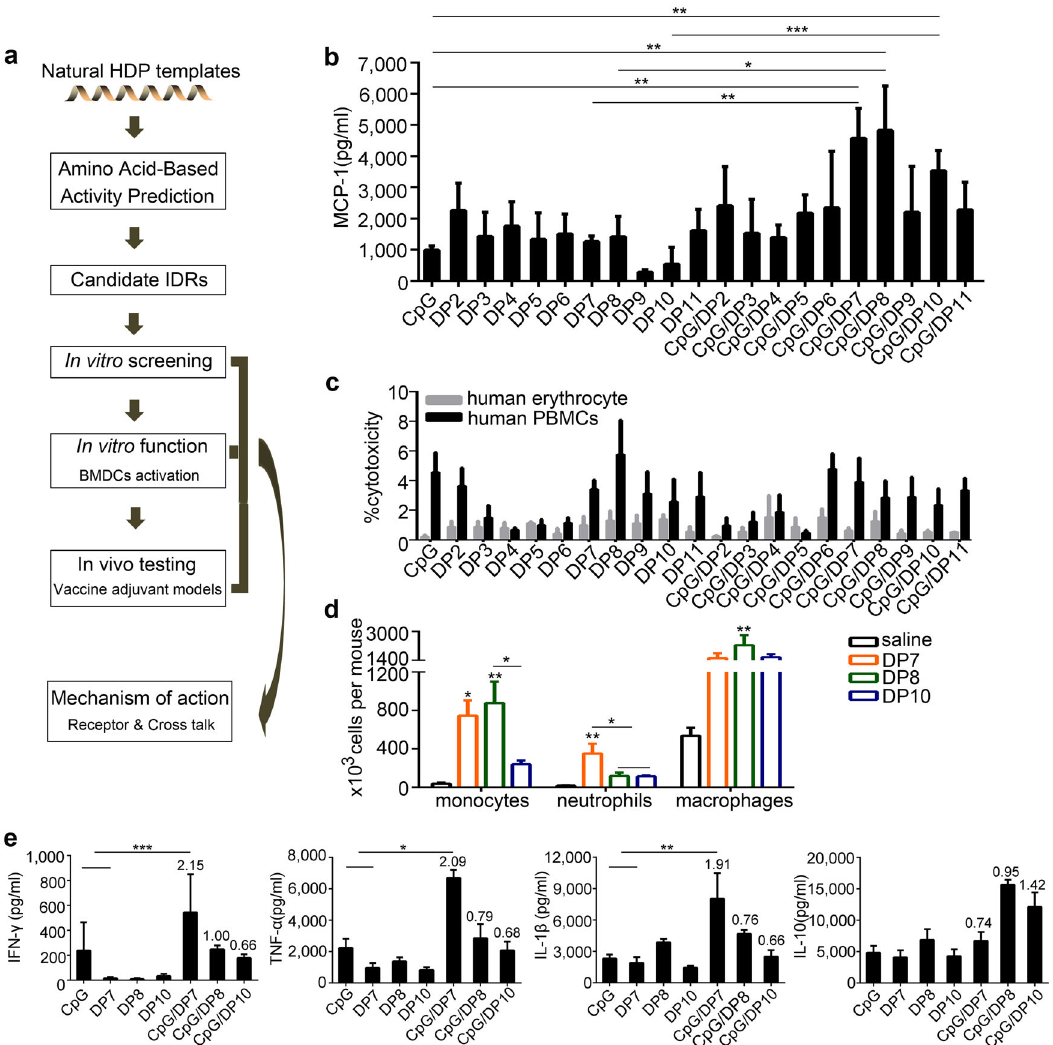
Fig. 1 In vitro preliminary screening of defense peptide candidates. a A representative fl owchart of the IDR design. b PBMCs were stimulated with CpG (20 µg/ml), DP2-11 (40 µg/ml), or CpG: DP2-11 (1:2; wt/wt) formulations for 24 h. The secretion of MCP-1 was detected by ELISA. c PBMCs or human erythrocytes were incubated with CpG (20 µg/ml), DP2-11 (40 µg/ml), or CpG/DP2-11 (1:2; wt/wt) formulations for 24 h. After that, the supernatants were collected, and LDH release from PBMCs and total hemoglobin release from red blood cells were measured. d DP7, DP8, and DP10 induced the signi fi cant recruitment of neutrophils (Gr1 + F4/80 − ), monocytes (F4/80 + Gr1 + ), and macrophages (F4/80 + CD11b + ) to the injection site at 24 h post-injection ( N = 5/group) . e PBMCs were stimulated with CpG (20 µg/ml), DP7 (40 µg/ml), DP8 (40 µg/ml), DP10 (40 µg/ml), CpG/DP7, CpG/DP8 or CpG/DP10 (1:2; wt/wt) formulations for 48 h. The secretion of the indicated cytokines was detected. N = 3 per group. Bars represent means and SEM. The numbers in the graph indicate the synergistic values. * P < 0.05; ** P < 0.01; *** P <